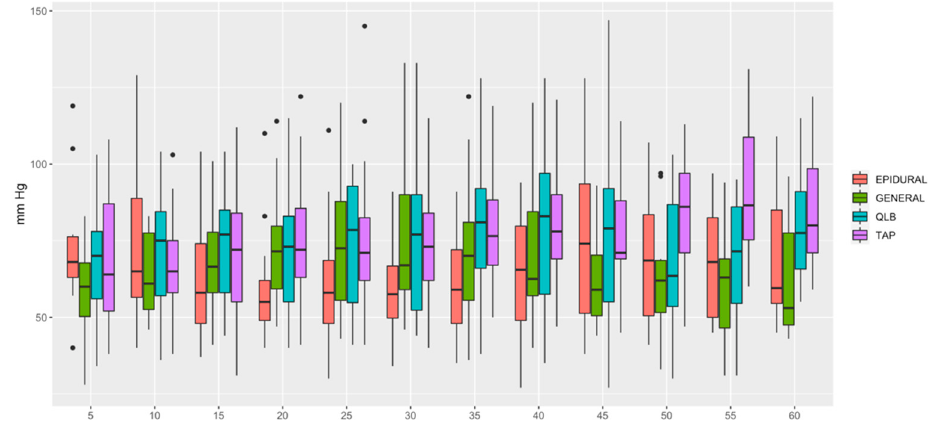
FeSEV (Figure 5) was lower in EPIDURAL than in GENERAL ( p = 0.00001), QLB ( p =